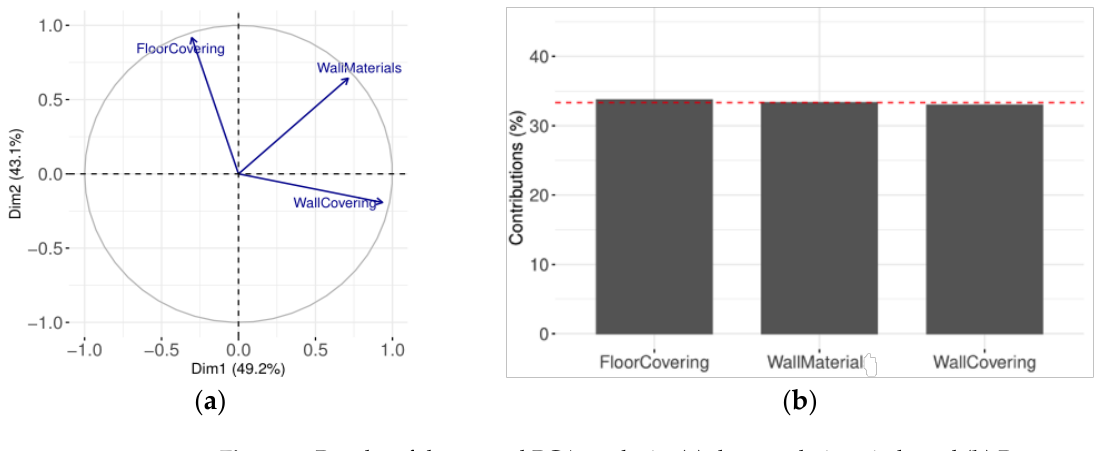
Figure 7. Results of the second PCA analysis : ( a ) the correlation circle and ( b ) Percentage contribu- tions of the factors that formed the main components (see Table 1).